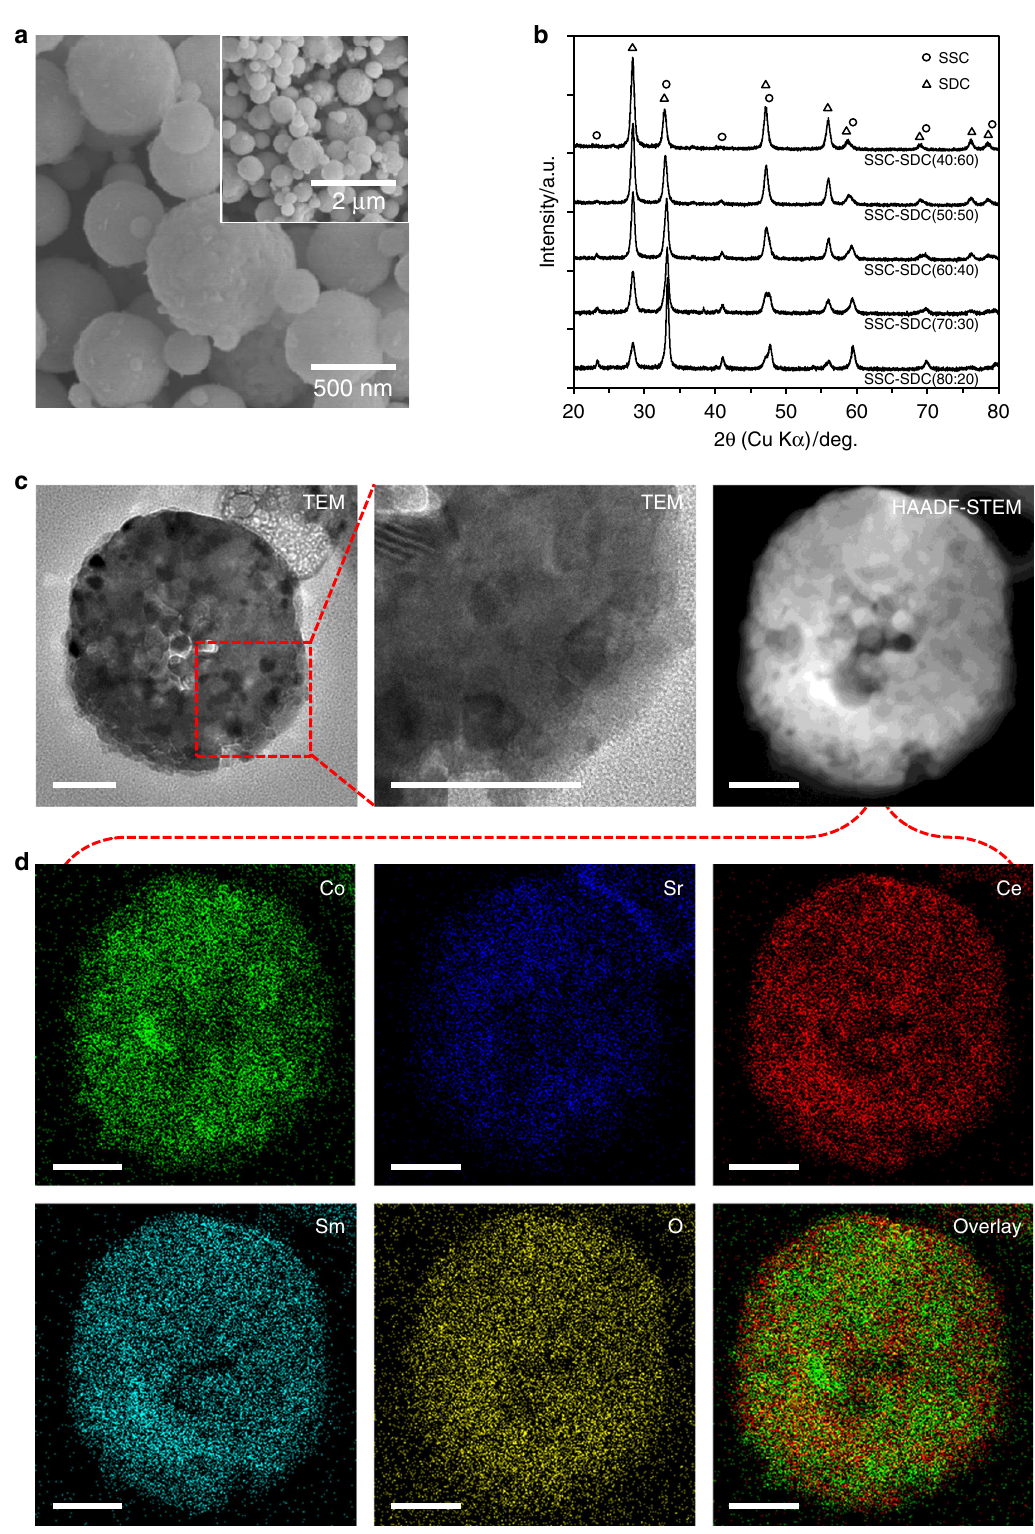
Fig. 2 Characterization of nanocomposite particles prepared by spray pyrolysis. a FE-SEM images of a representative SSC-SDC(50:50) nanocomposite particles. b XRD patterns for as-prepared SSC-SDC nanocomposite particles. c TEM and HAADF-STEM images and d EDX mappings of Co, Sr, Ce, Sm, and O of a representative SSC-SDC(50:50) nanocomposite particle. Overlay image of Co and Ce mapping is also shown. Scale bars in c and d indicate 100